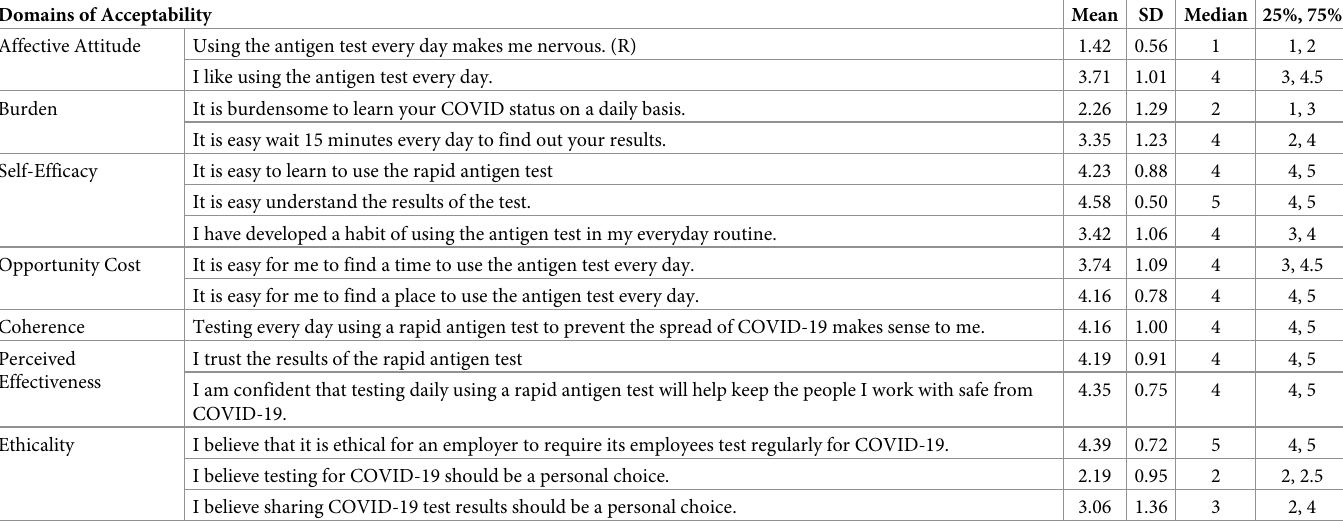
Table 3. Quantitative measurement of Sekhon’s domains of acceptability of a COVID-19 daily antigen testing regimen in an employment context (N =